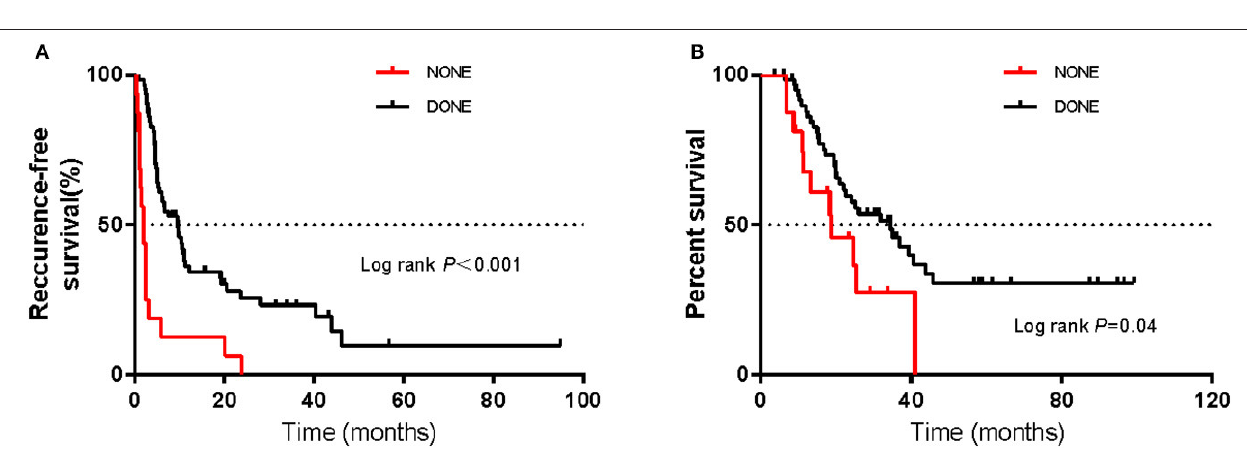
FIGURE 5 | Kaplan–Meier curves of (A) recurrence-free survival and (B) overall survival in patients receiving or not receiving post-operative therapy. The log-rank test was used to evaluate differences between